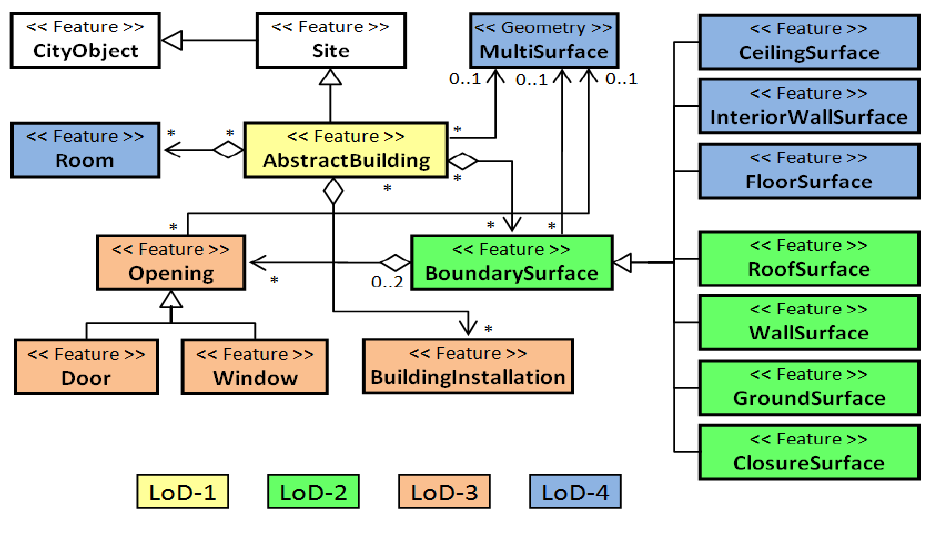
Figure 2. CityGML building model.